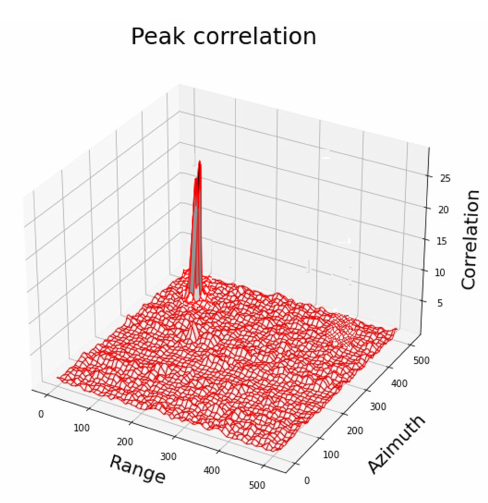
Figure 10. Correlation peak measured between 2 PAZ 64x64 pixel patches oversampled by a factor of 8 by zero